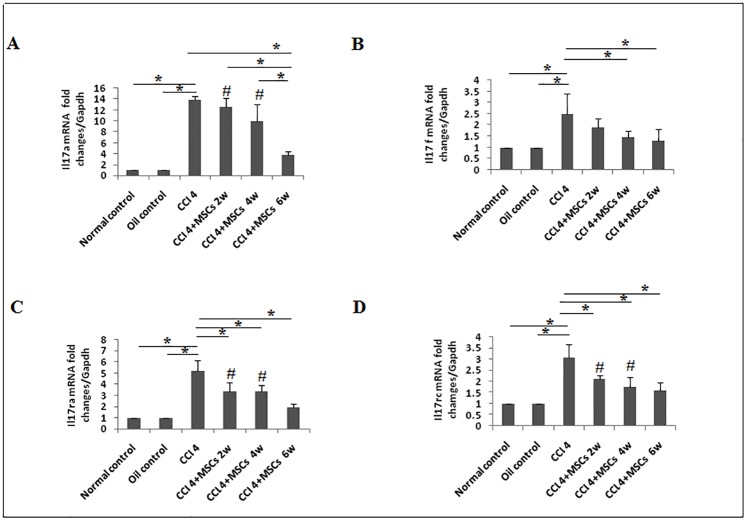
Expression of Il17a, Il17f, Il17ra, and Il17rc genes in liver tissue.The data are presented as fold induction of mRNA expression of a. Il17a, b. Il17f, c. Il17ra, and d. Il17rc in CCl4/untreated (n = 5) rats compared to MSCs transplanted (CCl4 +BM-MSCs) groups (n = 5) after 2, 4 and 6 weeks. All groups are compared with normal/diet control and oil/vehicle control rats (n = 5). Each experiment was performed in duplicates. Representative data are shown as mean±SD. *P<0.05. #P<0.05 compared to control groups.